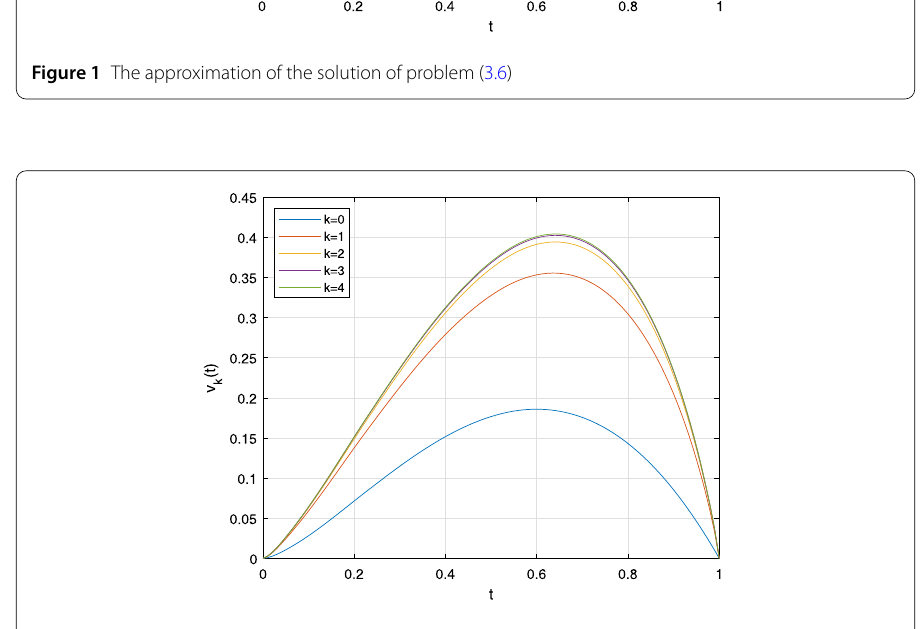
Figure 2 The approximation of the solution of problem